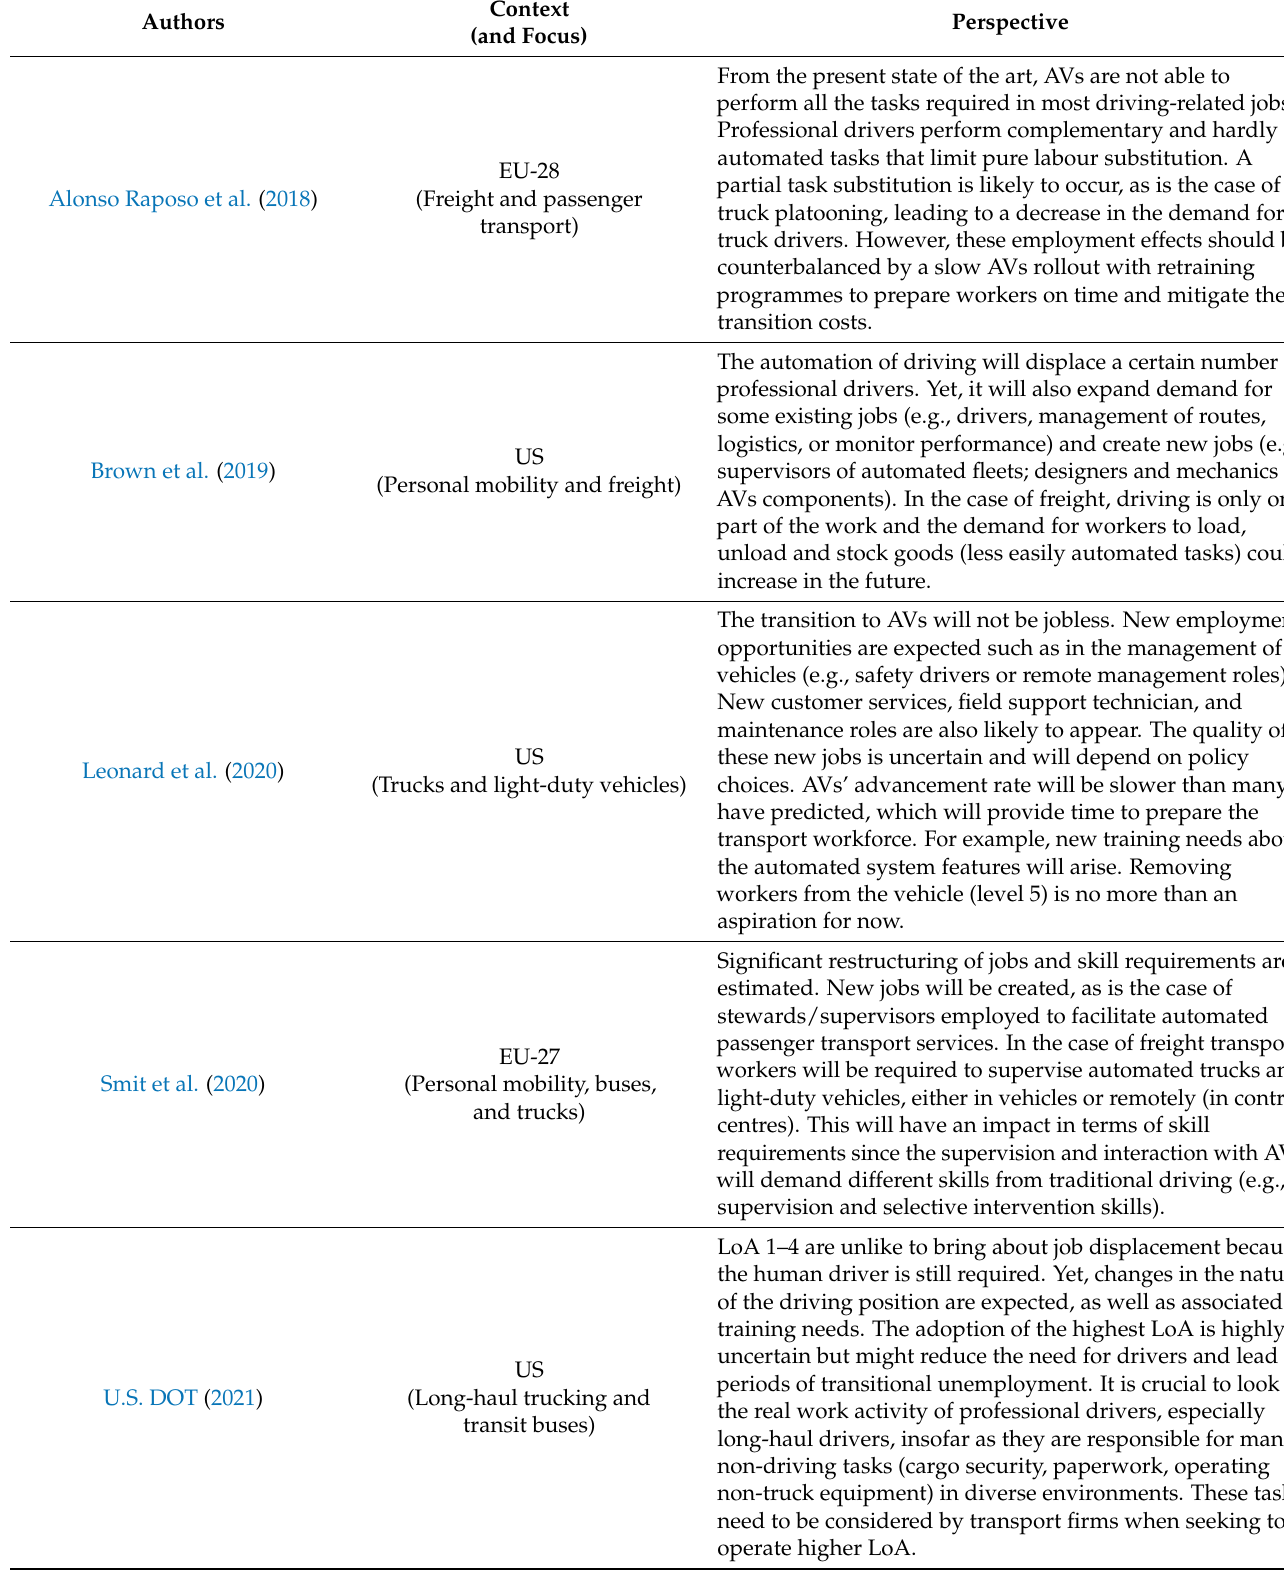
Table 1. Summary of the perspectives on potential AV-related impacts on the transport